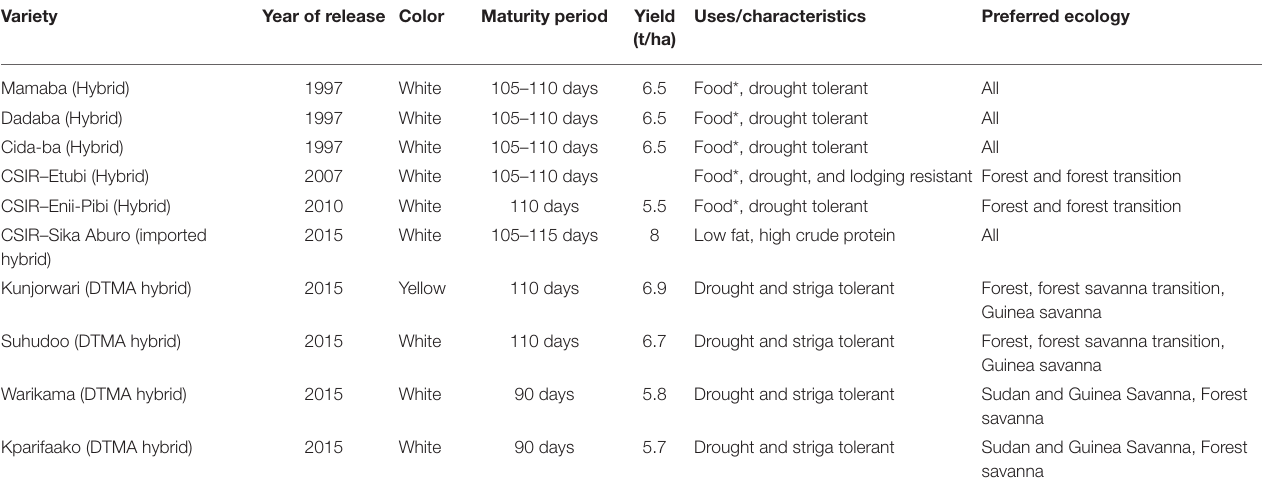
TABLE 1 | Hybrid maize varieties released in Ghana. Variety